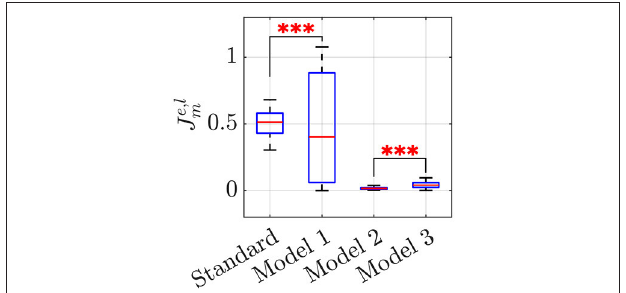
FIGURE 3 | Boxplots of J e , l m . Each sample represents the value of the cost function J e , l m for all the possible pairs of experimental and simulated trials, to compare the effectiveness of the l -th simulated trial in reproducing the e -th experimental data in each model m . A triple star corresponds to p < 0.001. See Table 4 for the average J e , l m and its standard deviation, in each model m .